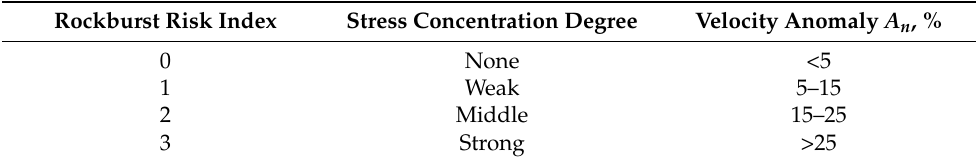
Table 2. Relation between velocity anomaly and stress concentration